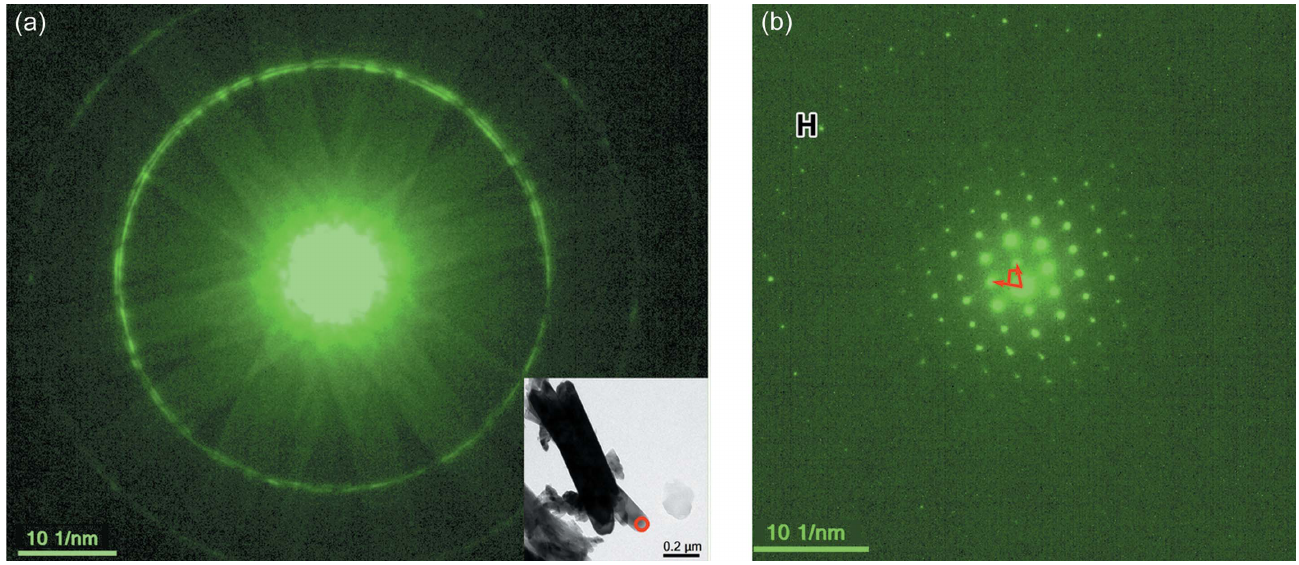
Figure 5 Determination of unit-cell parameters from a nano-rod TiO 2 oriented at ½ (cid:3) 112 (cid:3) 11 (cid:8) : ( a ) convergent-beam mode of TEM can provide a sharp HOLZ ring, ( b ) nano-beam mode of TEM can capture the electron diffraction from a small